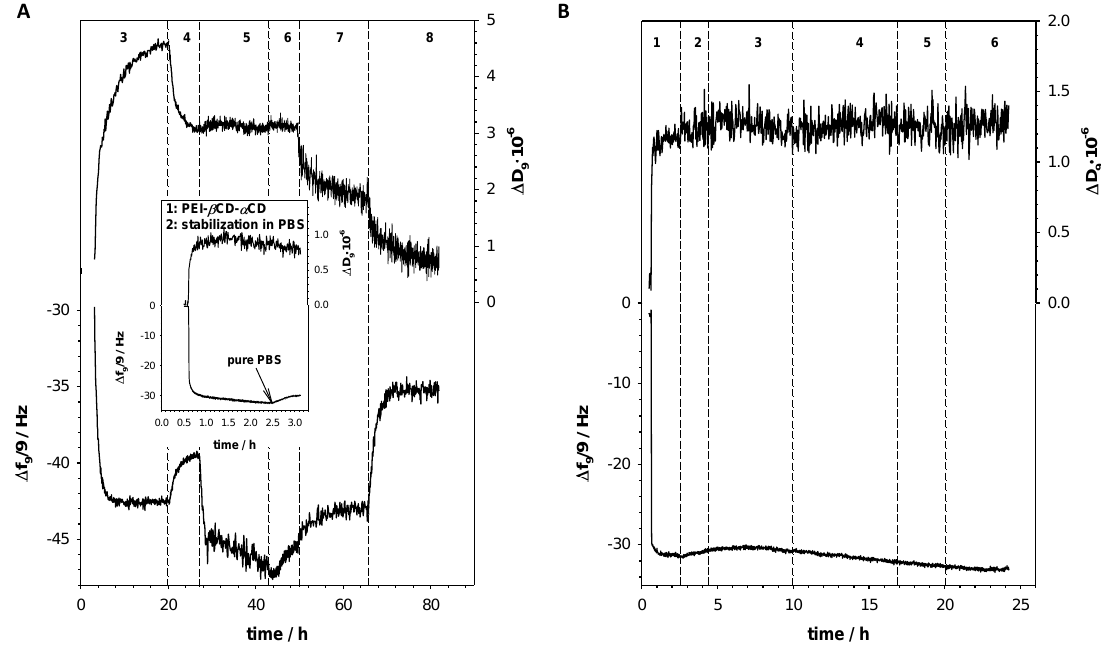
Figure 5. Typical QCM-D spectra of the shifts in frequency ( ∆ f ) and dissipation factor ( ∆ D ) recorded during subsequent steps of Au / PEI- β CD- α CD-FA ( A ) and Au / PEI ( B ) modification by DOX and beta-LP. Inset: Typical QCM-D spectra of the shifts in frequency ( ∆ f ) and dissipation factor ( ∆ D ) recorded during electrodeposition of PEI- β CD- α CD-FA and its stabilization. Experimental conditions: 0.02 M PBS (pH 7.4); C PEI- β CD- α CD = 0.25 mg · mL − 1 ; C DOX = 100 µ M; C beta-LP = 100 µ M. (1) Electrodeposition of PEI- β CD- α CD-FA ( A ) and PEI ( B ); (2) stabilization of PEI- β CD- α CD-FA ( A ) and PEI ( B ) layer in PBS bu ff er pH 7.4; (3) loading of DOX to PEI- β CD- α CD-FA ( A ) and PEI ( B ); (4) removing of unbounded DOX with PBS bu ff er pH 7.4; (5) loading of beta-LP to PEI- β CD(DOX)- α CD-FA ( A ) and PEI ( B ); (6) removing of unbounded beta-LP with PBS bu ff er pH 7.4; (7) degradation of PEI- β CD(DOX)- α CD(beta-LP)-FA at pH 5.5 (0.02 M PB buffer); (8) degradation of PEI- β CD(DOX)- α CD(beta-LP)-FA at pH 4.0 (0.02 M PB buffer).